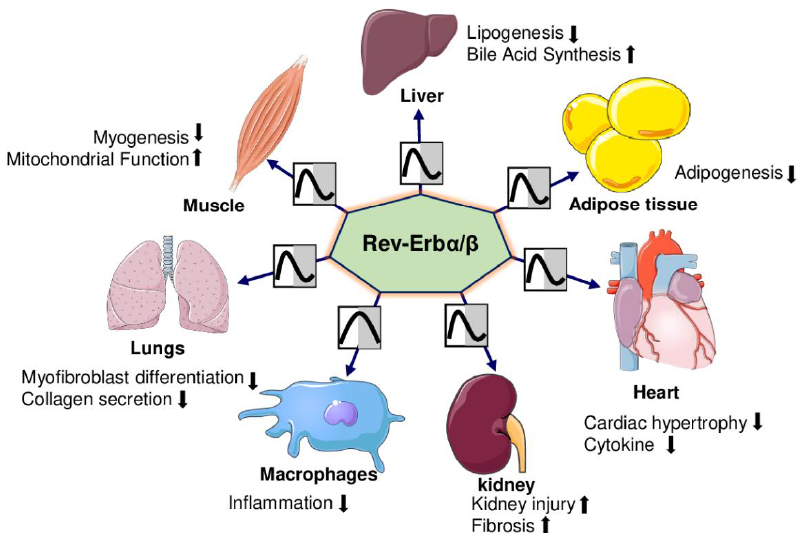
Figure 4. Rev- Erbα/βs display robust 24 h oscillations and regulate the physiological functions of the organs. Rev-Erbs reduce adipogenesis and lipogenesis and increase bile acid synthesis in adi- pose tissue and liver, respectively. Rev-Erbs reduce cardiac hypertrophy and inflammatory cyto- kines in the heart, myofibroblast differentiation, and collagen production in the lungs. Rev-Erbs decrease myogenesis and increase mitochondrial function in skeletal muscles. Rev-Erbs increase injury and fibrosis in the kidney. ( = decrease, = increase).